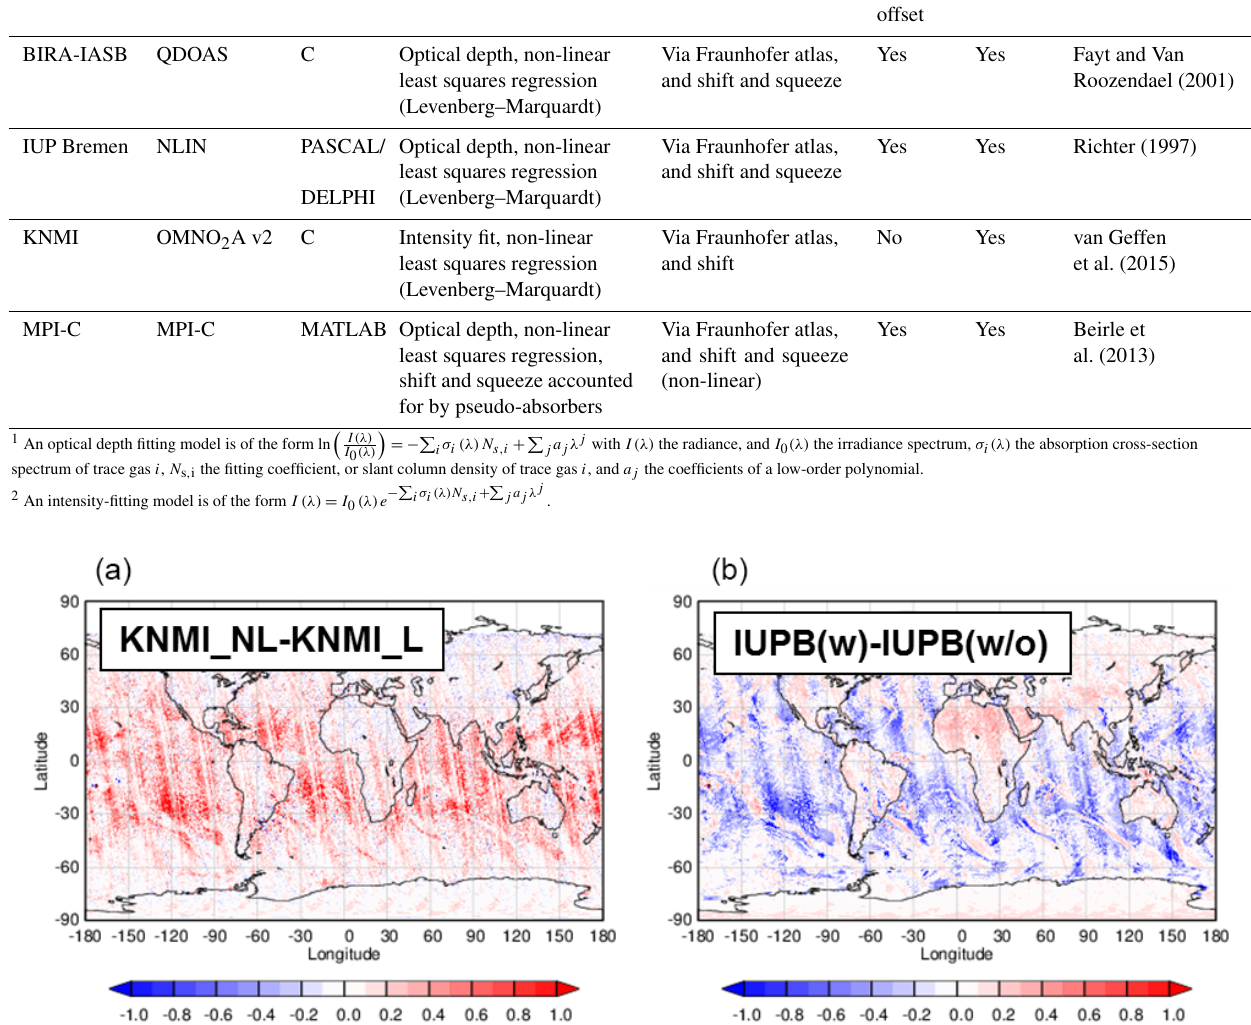
Table 3. Overview of OMI SCD retrieval codes from the QA4ECV consortium’s institutes. The common settings used for round 1 were a 405–465nm fitting window, polynomial degree of 4, and inclusion of O 3 , NO 2 , O 2 − O 2 , and H 2 O, Ring cross sections, use of mean solar irradiance as reference spectrum. The cross sections have been convolved with the OMI slit function for each row separately. Institute